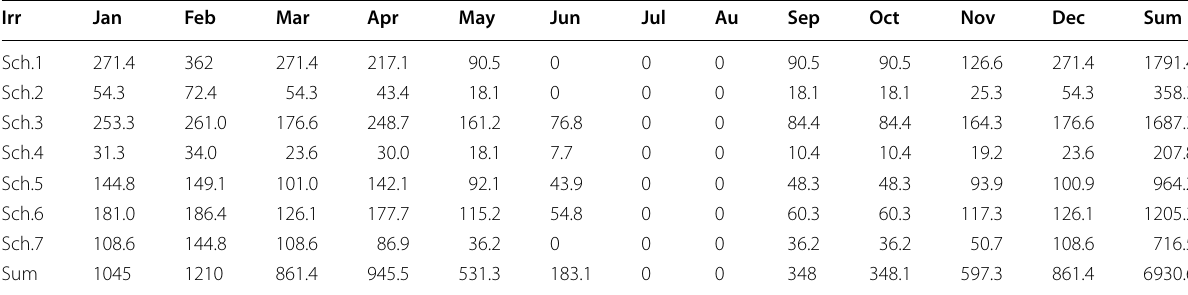
Table 6 Monthly Irrigation demand per scheme (‘000 m3)